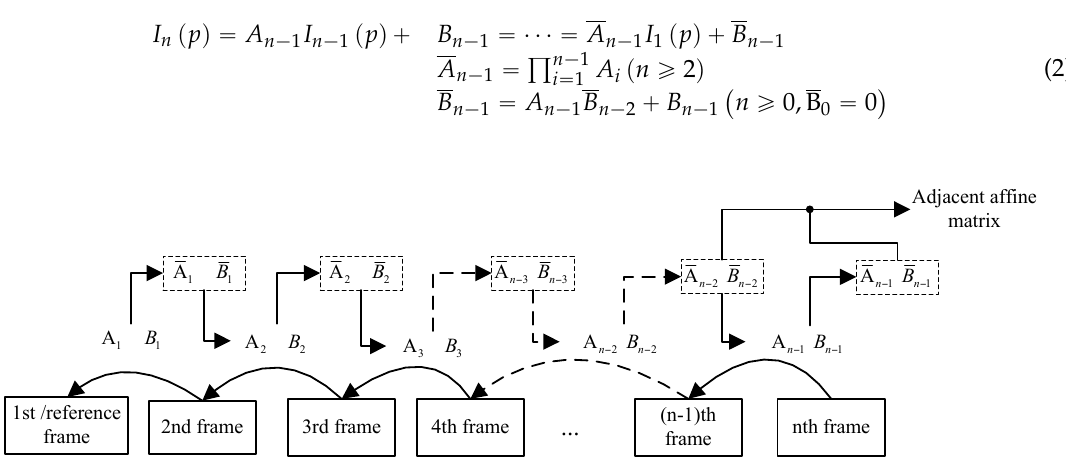
Figure 3. Adjacent affine model defined by using cascading parameters in the video sequences.